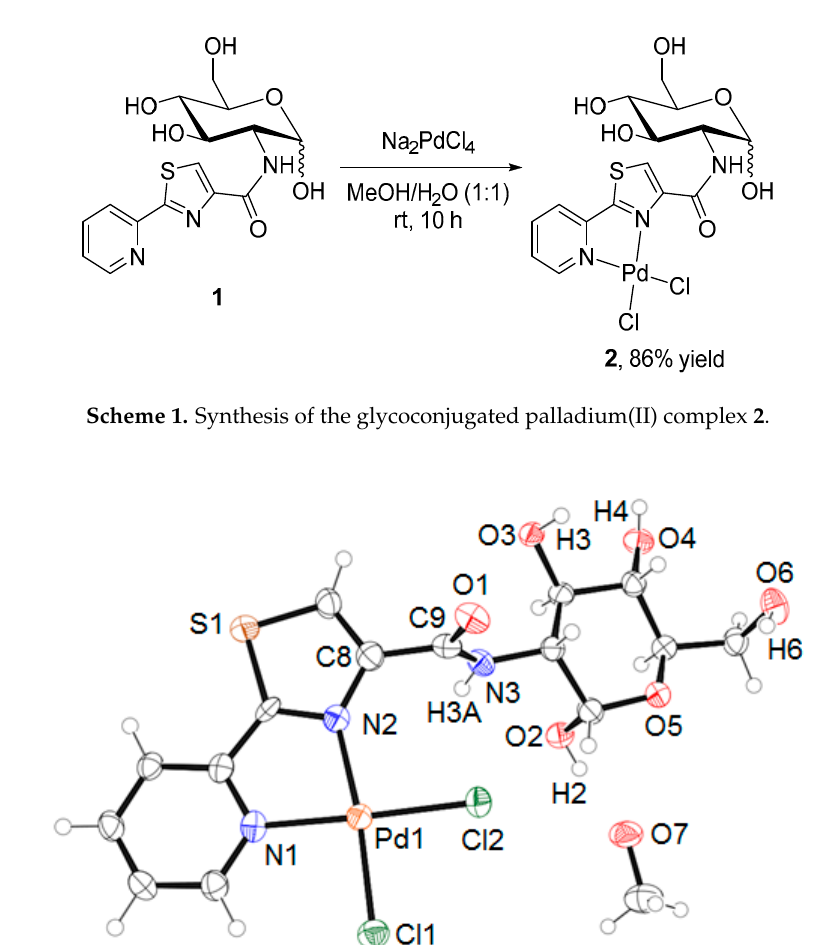
Figure 1. Crystal structure of 2 ·MeOH with numbered atoms. Ellipsoids are shown at the 50% probability level. Hydrogen atoms were added automatically except for H2, H3, H4, H6, and H3A. The absolute configuration of complex 2 were established by the structure determination of the D -glucopyranose moiety of known absolute configuration and confirmed by anomalous-dispersion